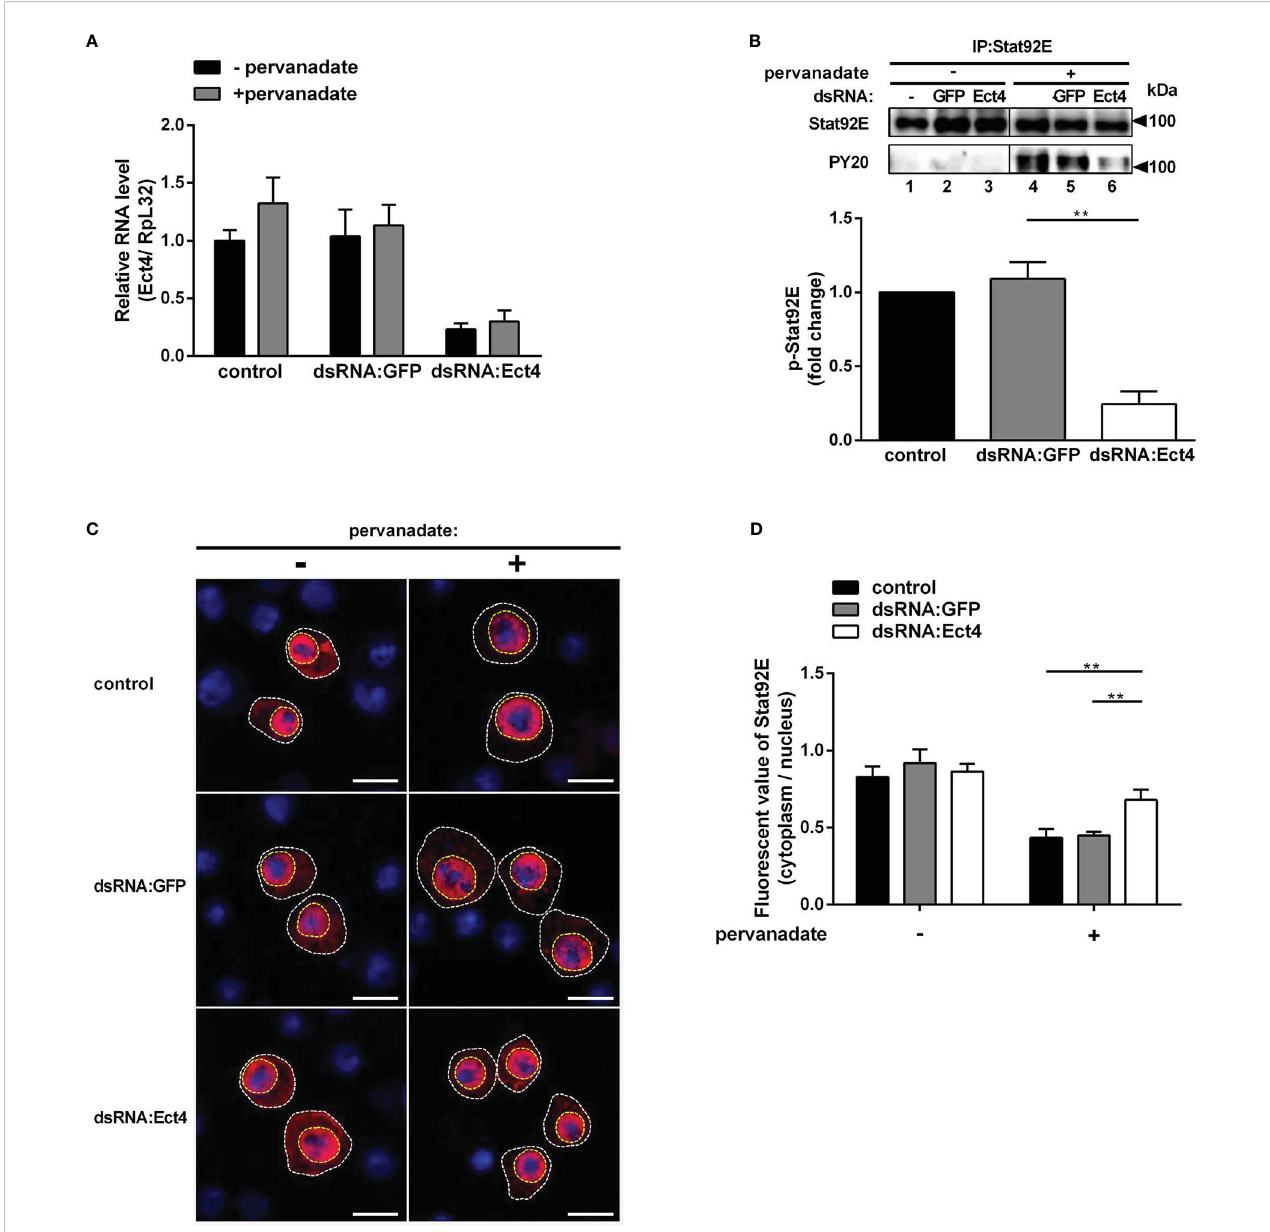
FIGURE 6 Knockdown of Ect4 mRNA decreased the phosphorylation of Stat92E. (A) S2 cells were pretreated with or without dsRNA targeting GFP or Ect4 transcripts for 72 h, and measurement of Ect4 mRNA by RT-qPCR to con fi rm RNAi ef fi ciency. (B) After dsRNA treatment, S2 cells were either unstimulated or treated with pervanadate. Stat92E proteins were immunoprecipitated with Stat92E antibody, followed by immunoblot analysis with the Stat92E or PY20 antibodies. In the absence of pervanadate, phosphorylated-tyrosine Stat92E (p-Stat92E) was undetectable (lane 1-3). In contrast, after pervanadate treatment, p-Stat92E increased to levels detectable by western blot (lanes 4-6). The phosphorylated Stat92E was quanti fi ed from n = 3 independent experiments. (C) After transfection with Stat92E-HA, S2 cells were treated with or without dsRNA targeting GFP or Ect4 for 72 h and then left unstimulated or treated with pervanadate. Cells were stained with anti-HA antibody (red) and DAPI (blue) and imaged by confocal microscopy. (D) Quanti fi cation assays of the ratio between the fl uorescent signal intensity of Stat92E in the nucleus (surrounded by a yellow dashed line) and in the cytoplasm (the area in the white dotted line subtracts the area from the yellow dashed line). Cell samples collected from (C) , n=15. Scale bar: 10 m m. Data represent the means ± standard errors. The t- test (B, D) : ** P <